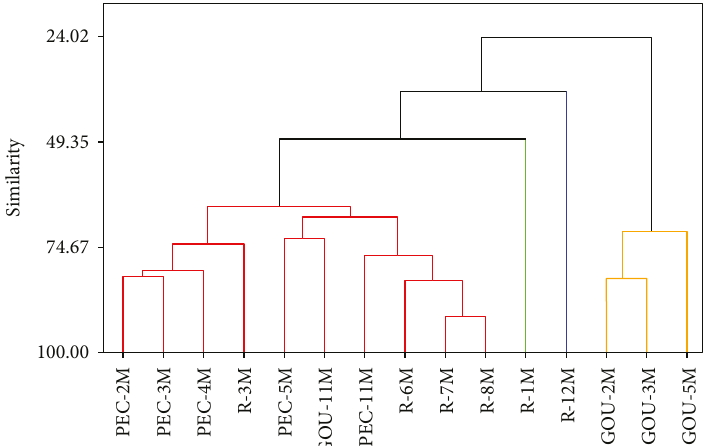
Figure 4: Hierarchical cluster analysis of the 15 samples of Pecorino (PEC), Gouda (GOU), and ewes ’ ripe (R) varieties of cheese. The ripening times are represented by its number followed by M